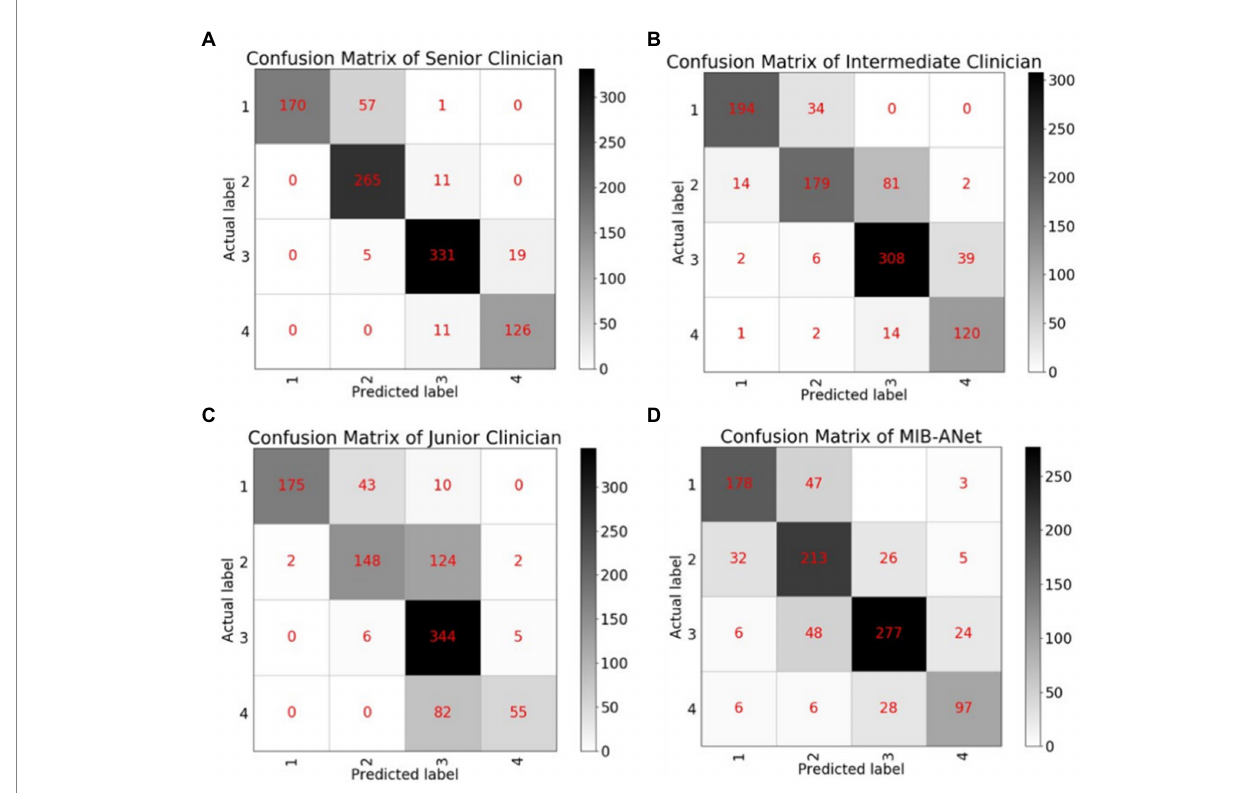
FIGURE 4 The confusion matrices of MIB-ANet and 3 clinicians. (A–D) Show the confusion matrix of senior clinician, intermediate clinician, junior clinician, and MIB-ANet,